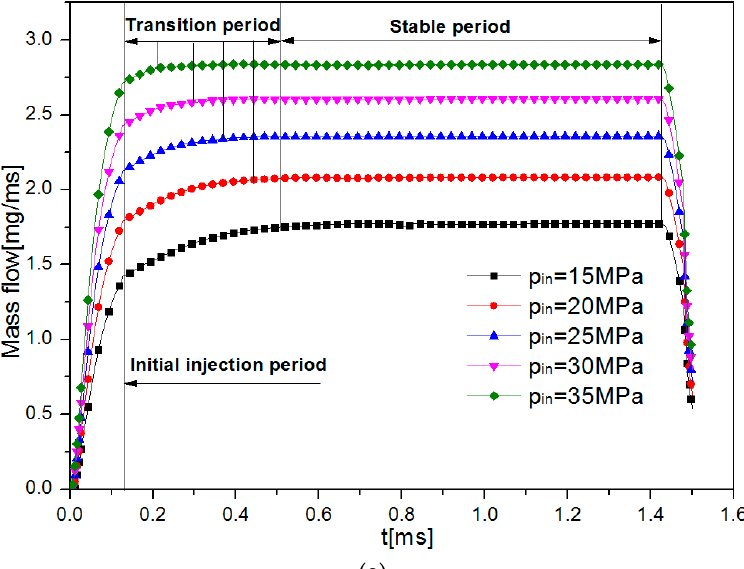
Figure 5. Comparison of experimental data and simulation result. ( a ) Grid independency, ( b ) Mass flow